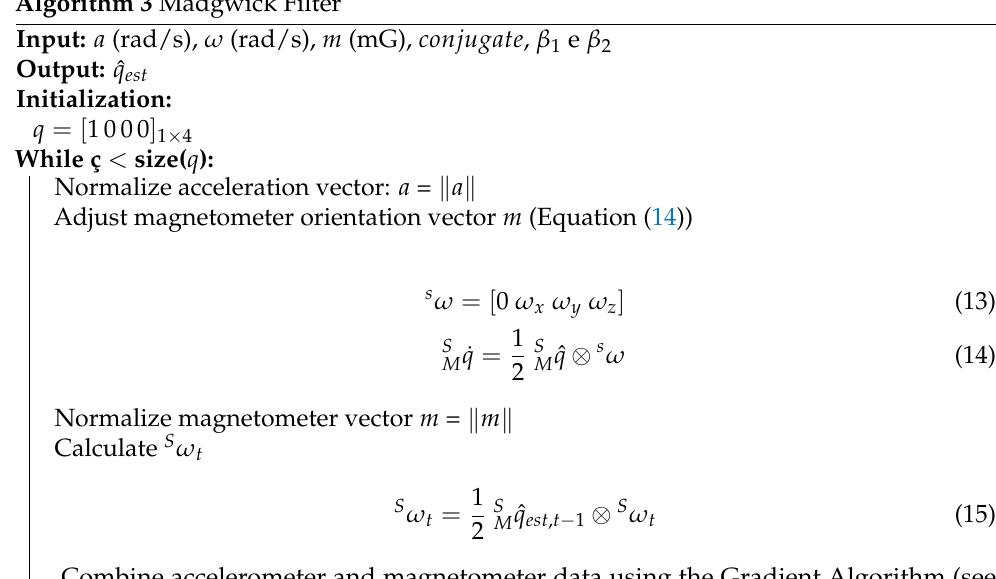
Algorithm 3 Madgwick